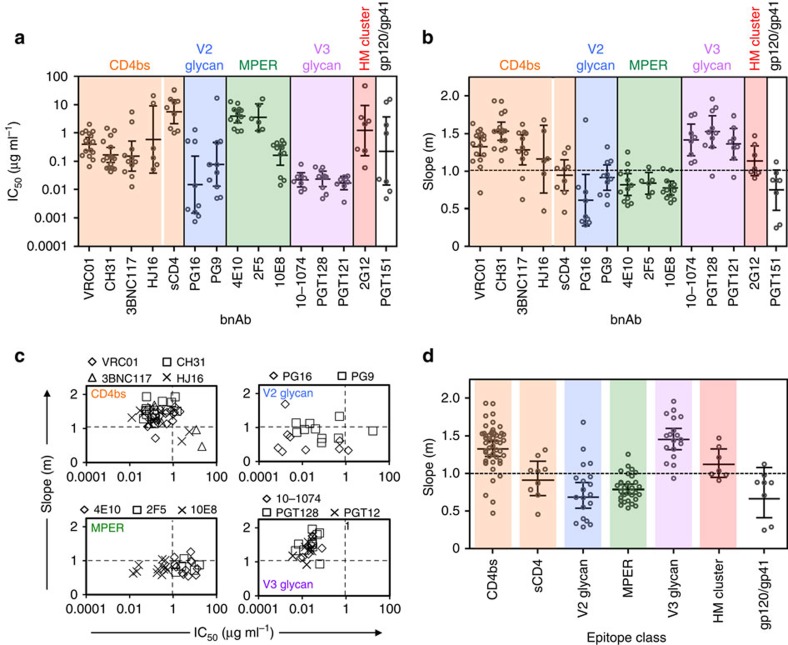
Slope and IC50 characteristics of bnAb epitope classes.(a) IC50 and (b) slope values of bnAbs and sCD4 (bottom categories) against each Env in our panel (circles). Bars indicate geometric mean IC50s with 95% confidence interval (CI) or mean slopes with 95% CI. Antibodies are grouped by epitope class (top categories). (c) Landscape of slope and IC50 values for CD4bs (top left), V2-glycan (top right), MPER (bottom left) and V3-glycan (bottom right) bnAb classes. Dashed lines indicate quadrants of high/low IC50 and high/low slope. (d) Slopes of each bnAb epitope class against each Env in our panel. Bars indicate mean and 95% CI. All data shown are from bnAb/Env combinations that achieved complete neutralization and are derived from median-effect fits of two-replicate averages.